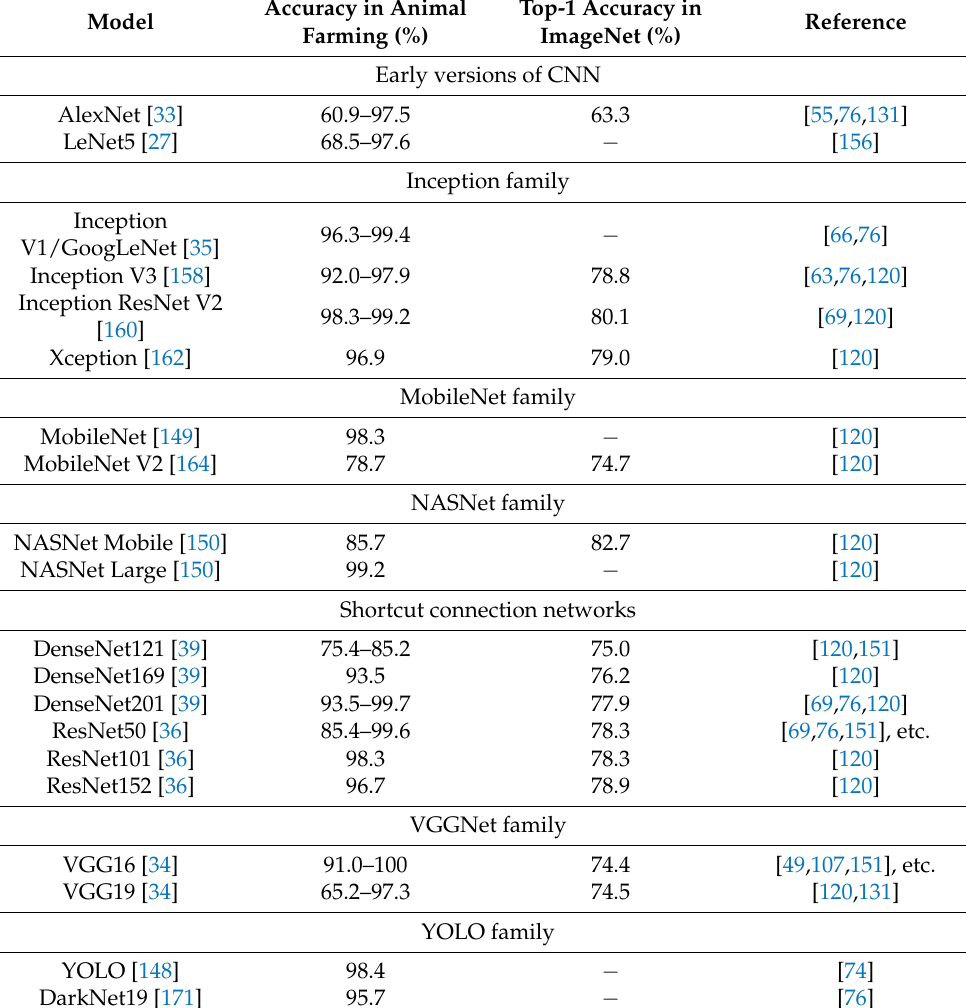
Table 9. Accuracy of architectures for image